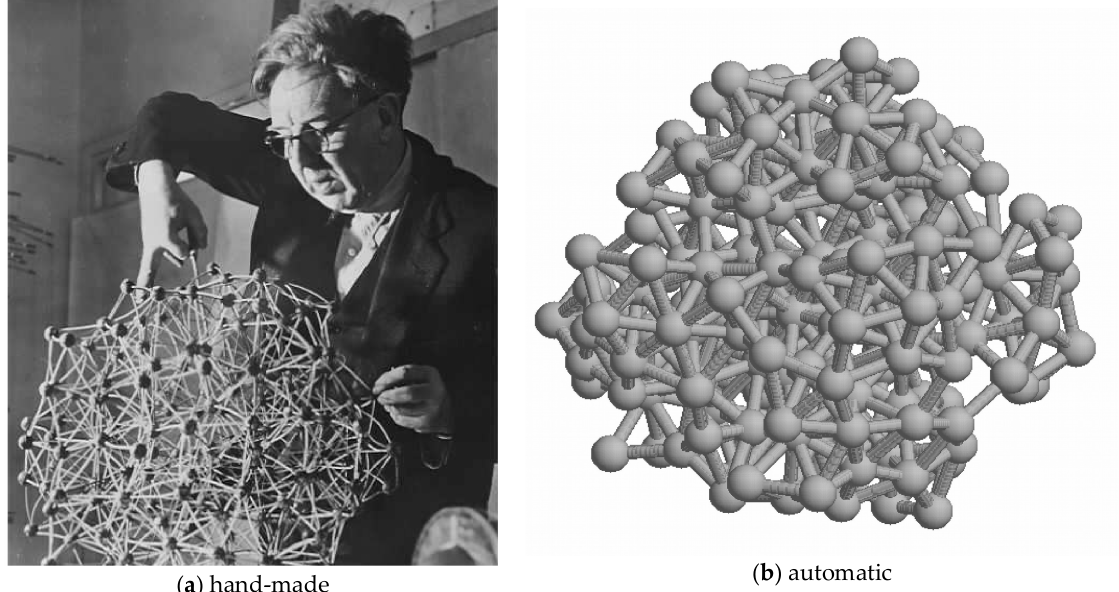
Figure 8. A Bernal lattice: ( a ) J. D. Bernal in the 1960s working on his model for liquid water based on tetrahedral “packing”. Since tetrahedra cannot tile space, this is a pseudo-lattice incorporating many discontinuities (hence the liquid nature of water). ( b ) A more recent computer-generated version (made with a program written by the author).